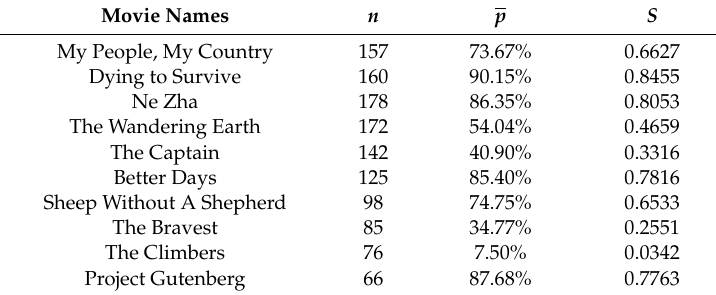
Table 2. 2020 Hundred Flowers Award favorite questionnaire.